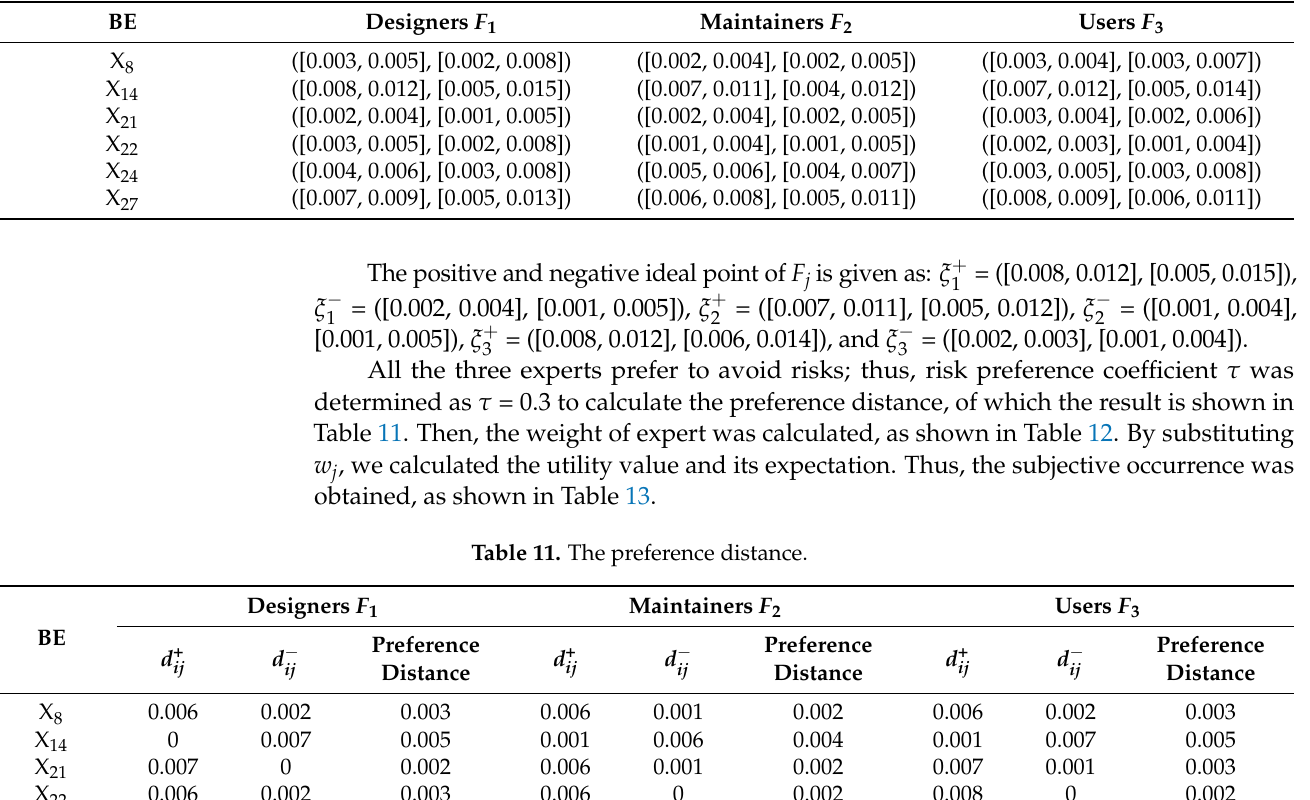
Table 10. The occurrence estimation given by experts.